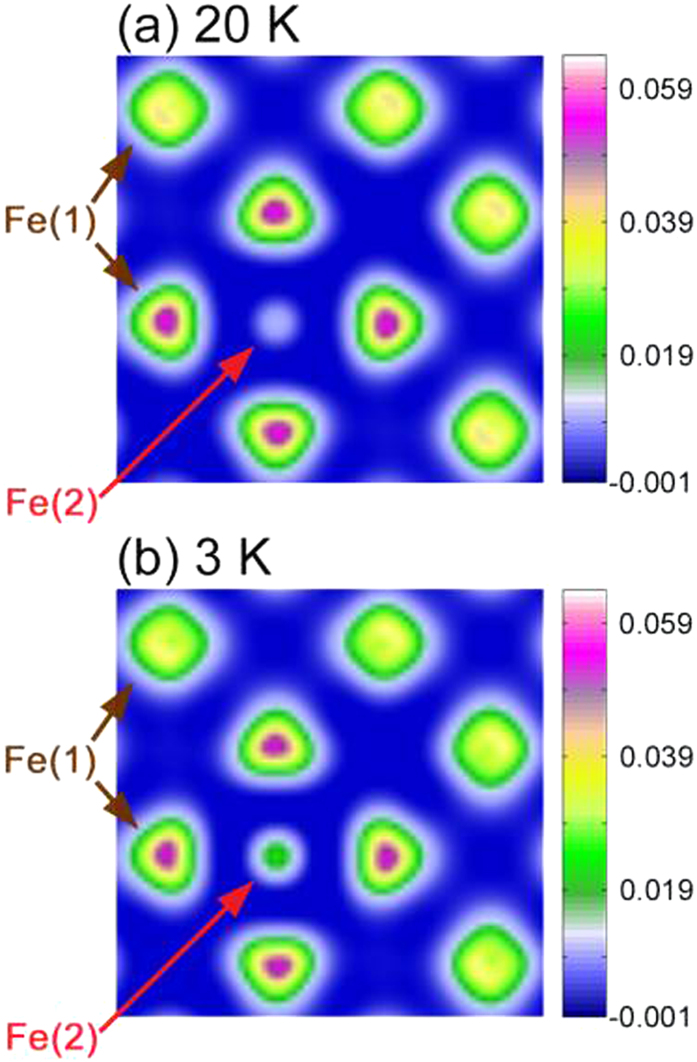
Contour plots of the spin density, s(r), in the (0 0 0.89) plane of Fe1.125Te0.5Se0.5 at (a) 20 K and (b) 3 K. The spin density around the Fe(2) ions is noticeably higher at 3 K than that at 20 K.